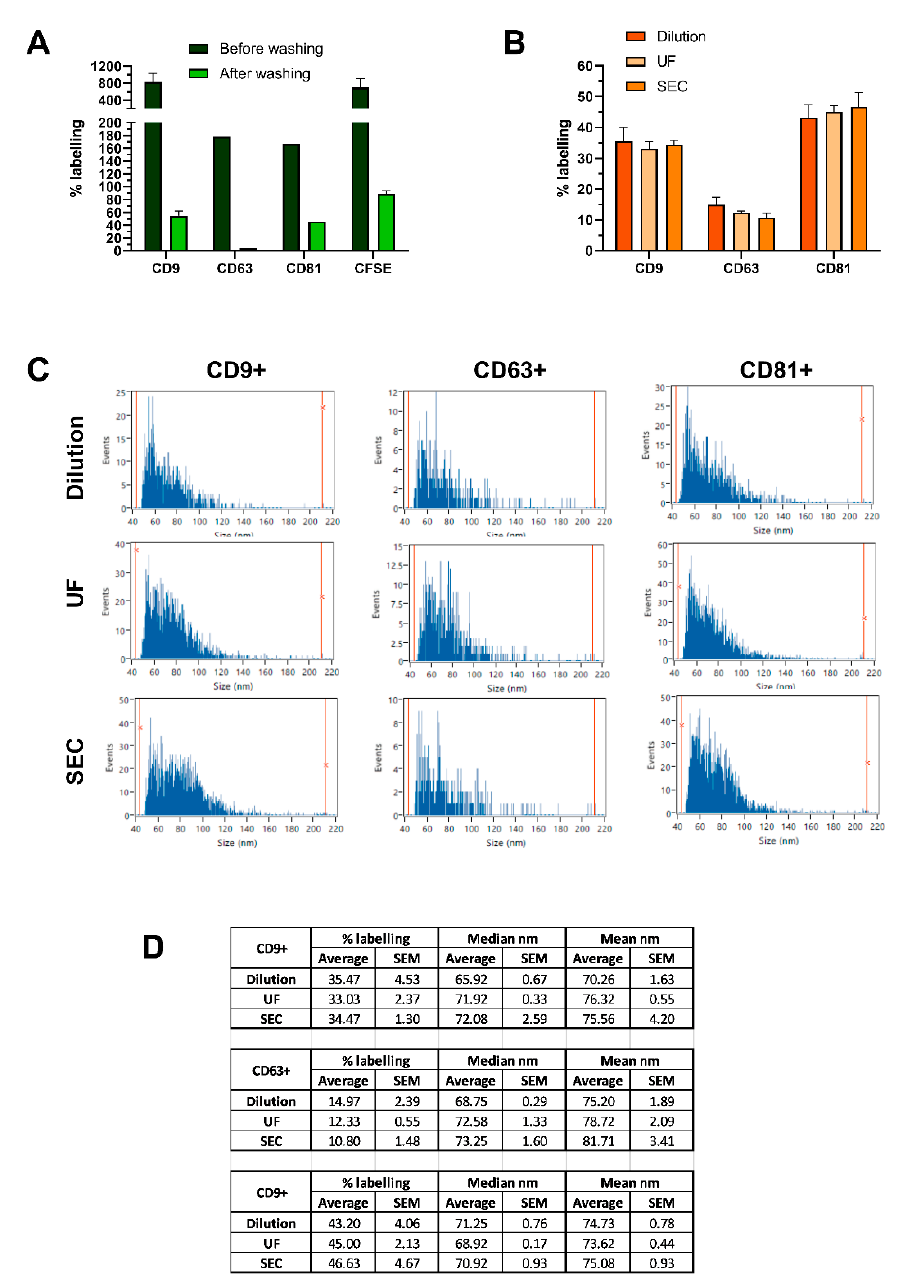
Figure 3. Suitability of SEC and UF as methods for clearing dyes in excess after sEV fluorescent labeling and their effect on subpopulation ratios. ( A ) Comparison of labeling % for stained HT29 sEVs before and after the removal of excess dye. 1 × 10 9 or 5.5 × 10 9 sEVs were incubated with antibodies (aCD9 1:12.5; aCD63 1:12.5; aCD81 1:25) or CFSE (50 µ M), respectively, and measured by F-NTA. To remove the excess dye, UF washing strategy was applied, followed by F-NTA detection. ( B ) To compare different strategies for the removal of fluorescent antibodies in excess, labeling %, ( C ) PSD histograms, and ( D ) median and mean particle diameter were assessed for CD9+, CD63+ and CD81+ HEK293 sEVs, on nFCM. 2 × 10 9 sEVs, at a concentration of 10 8 particles/ µ L, were incubated with PE-labelled antibodies (aCD9 1:500; aCD63 1:25; aCD81 1:500) and unbound antibodies were removed by SEC or UF. Sample dilution (500–1000-fold) served as staining reference. Data is presented as mean ± SEM of at least three independent experiments. F-NTA PSD histograms of samples analyzed before and after washing are provided in Supplementary Figure